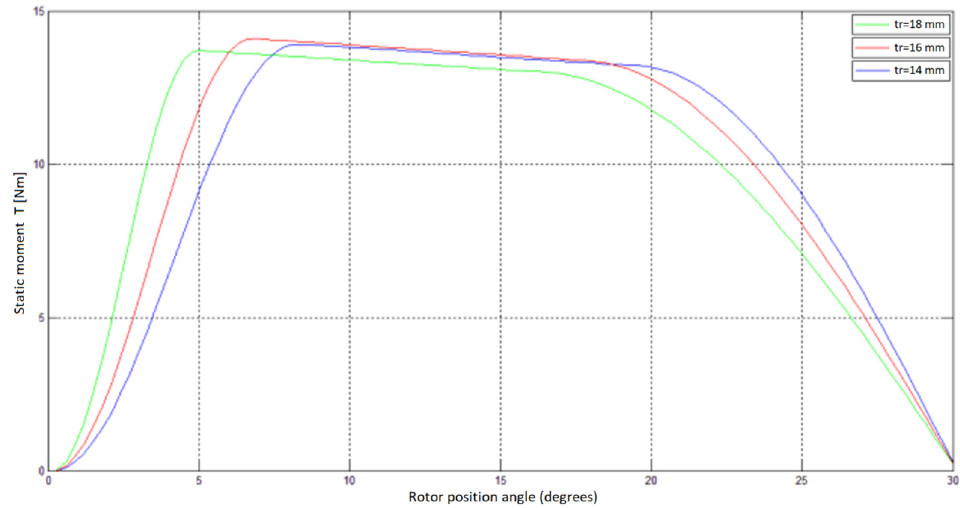
Figure 14. Simulated family of static torque characteristics as a function of the position angle and different width of the rotor poles t r of the rotor at I ph = 25 A.